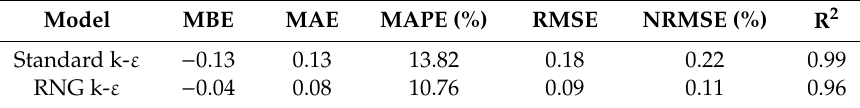
Figure 6. Experimental and numerical results of S i /( d · F ). Table 4. Error indices of the numerical models for S i /( d · F ).